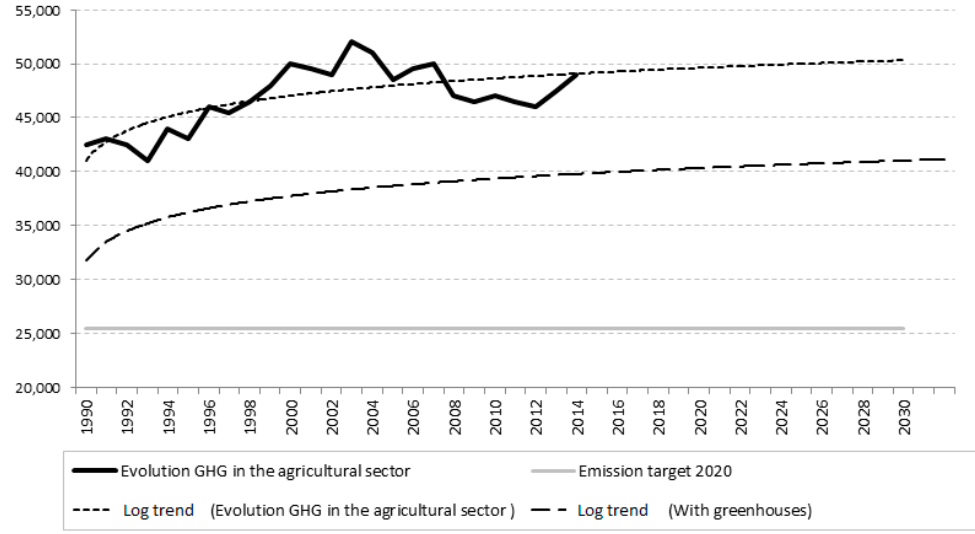
Figure 7. Spanish emissions trend in agricultural and livestock sector (MtCO 2Eq ) ([65], Authors’).